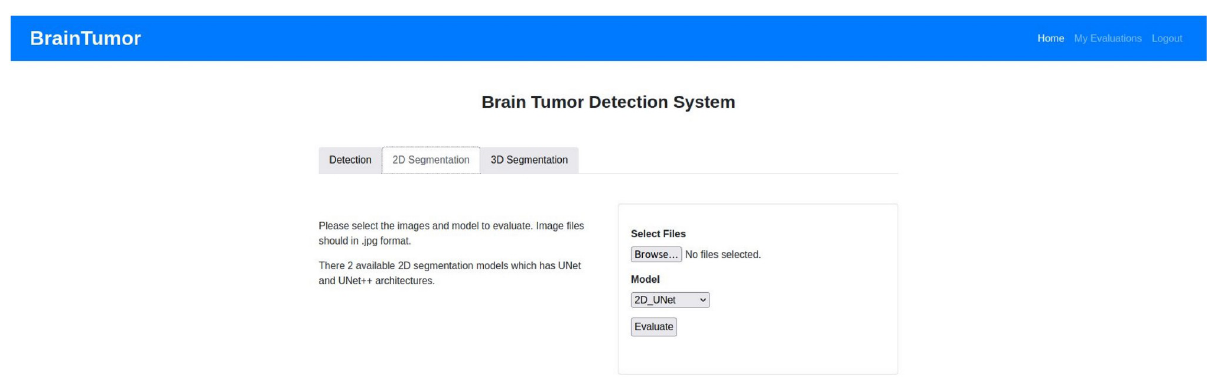
Fig 16. 2D segmentation page.